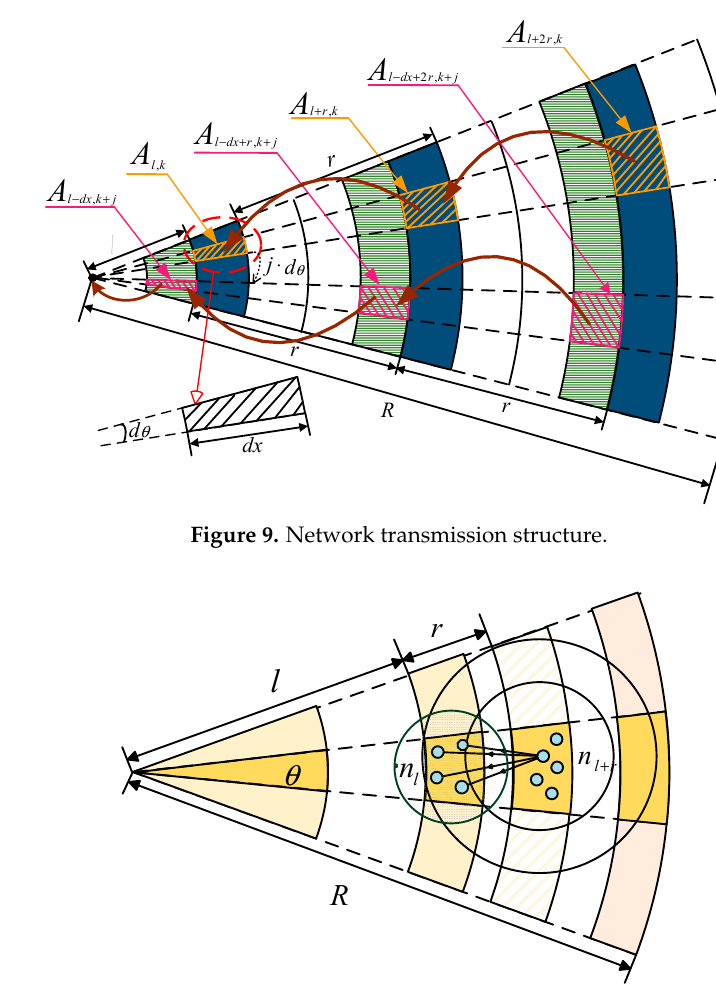
Figure 10. Calculation diagram of data volume.